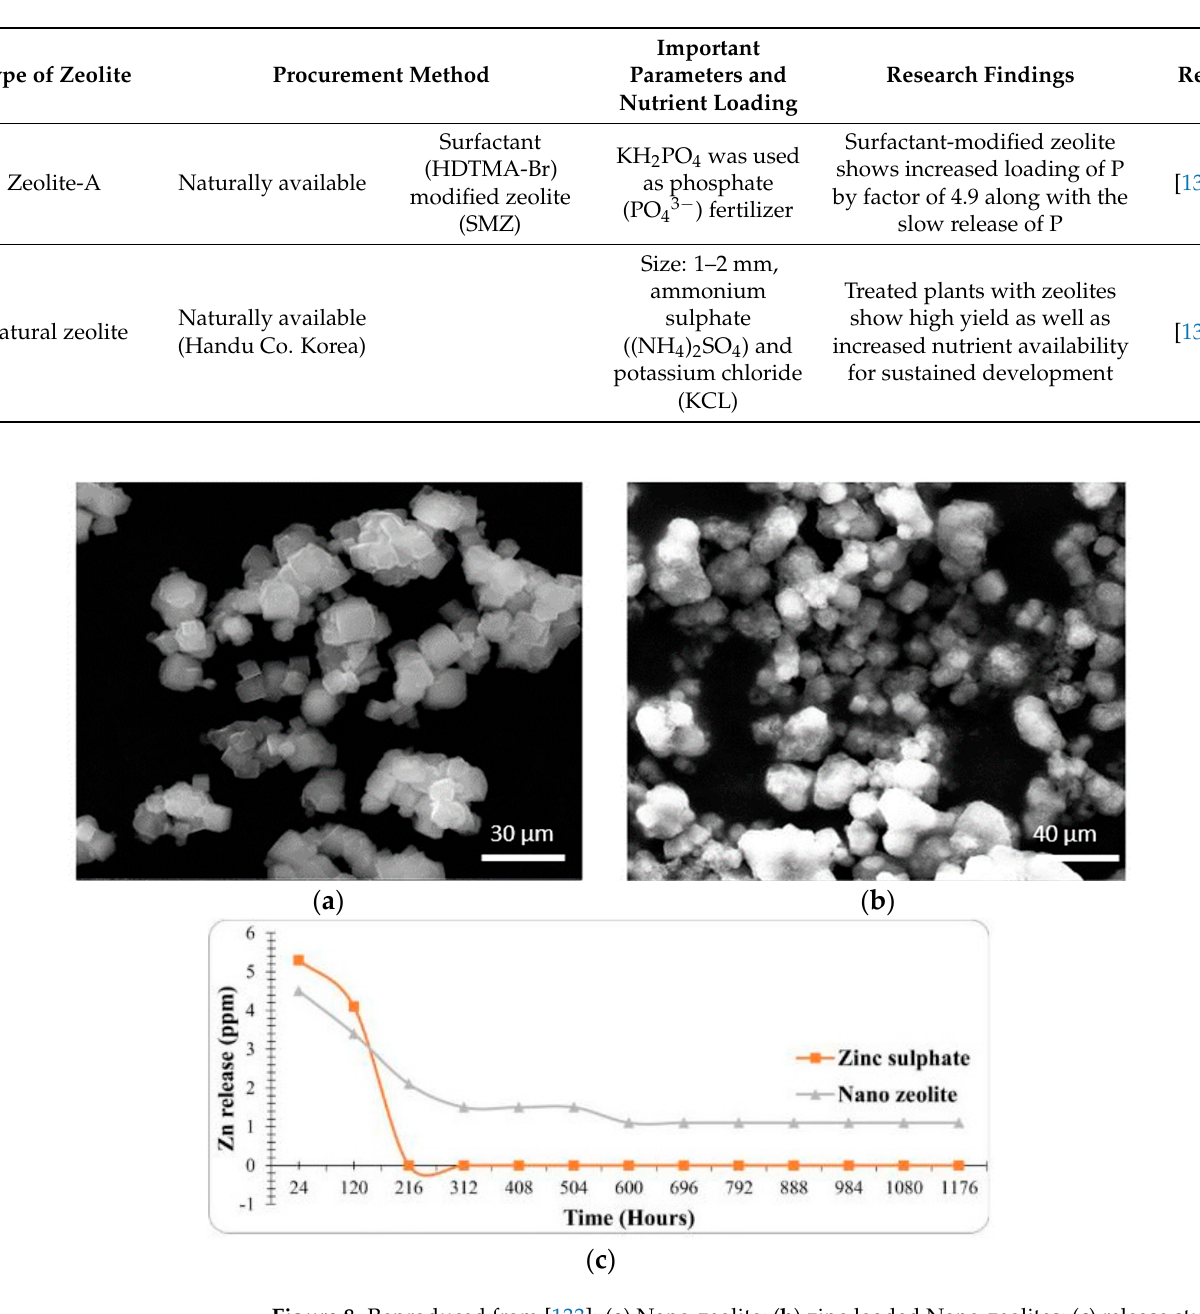
Table 2. Zeolites as carriers of micro- and macronutrients.